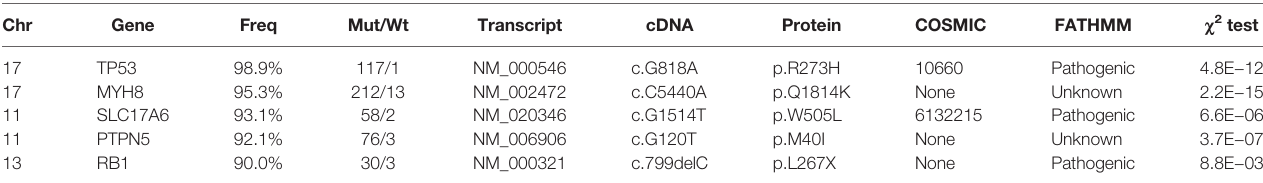
TABLE 1 | High allele frequency mutations identi fi ed by WES in the tumor